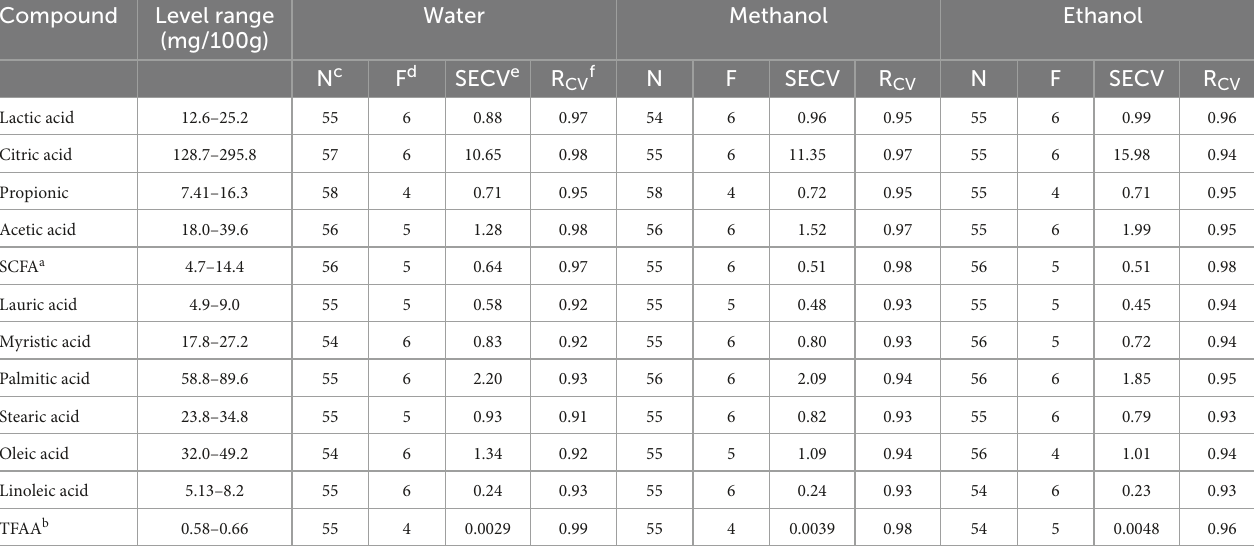
TABLE 3 Performance statistics of the calibration models developed using FT-IR, for the prediction of free amino acids, organic acids, and free fatty acids in soluble extracts (water, methanol, and ethanol) samples during the ripening period. Compound Level range Water (mg/100g)